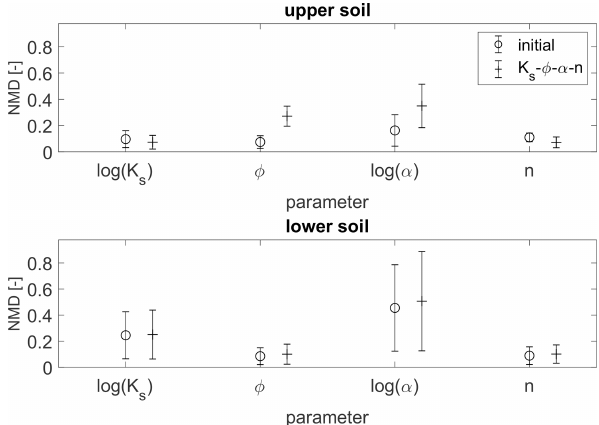
Figure 12. Normalized mean deviation (NMD) of the estimated pa- rameter fields compared to the reference field for the two soil layers of the heterogeneous scenario. The error bars denote the standard